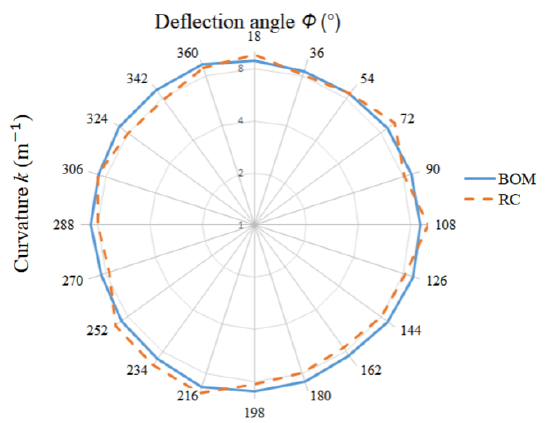
Figure 9. Schematic diagram of the manipulator’s maximum bending curvature with the deflection angle varying.